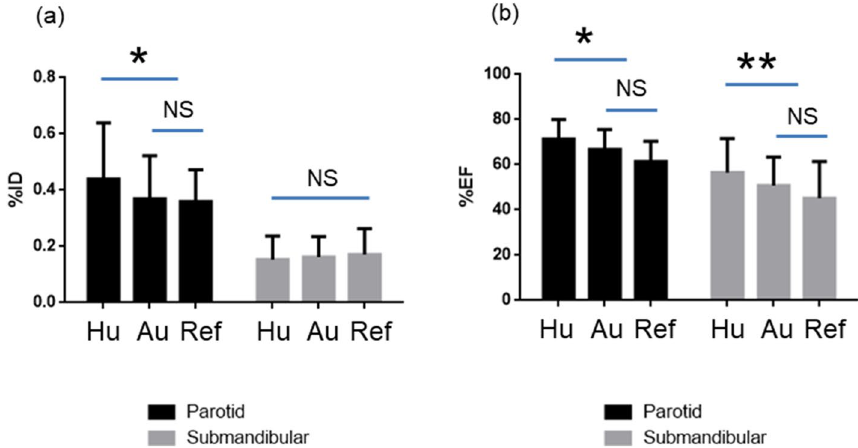
Figure 4. Comparison of segmentation results in normal salivary glands regarding the ( a ) %ID and ( b ) %EF between a human beginner (Hu) and the automatic segmentation algorithm (Au) in comparison with the reference results (Ref). The trainee generated significantly greater parotid %ID (* p < 0.0001), parotid %EF (* p < 0.0001), and submandibular %EF (** p = 0.0003), but the automatic algorithm produced equivalent %ID and %EF in both the parotid and submandibular glands ( NS not